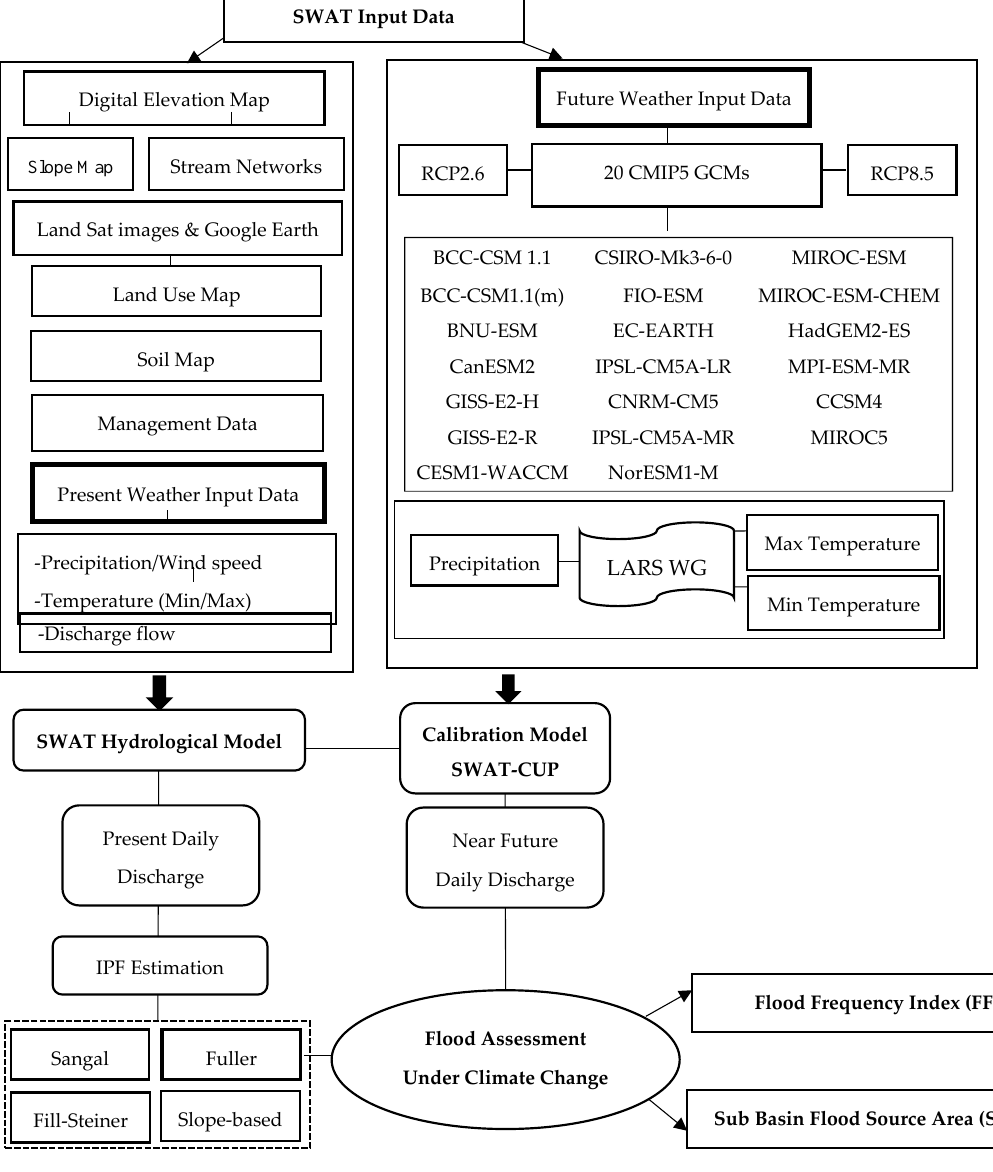
Figure 3. Schematic of applied methodology in this study.